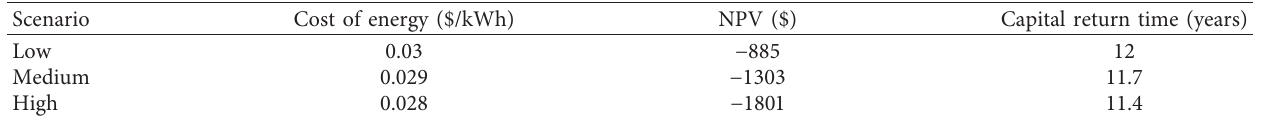
Figure 7: Schematic of energy balance for different solar fraction scenarios. (a) Low. (b) Medium. (c) High. Table 4: Results of economic analysis performed for the studied